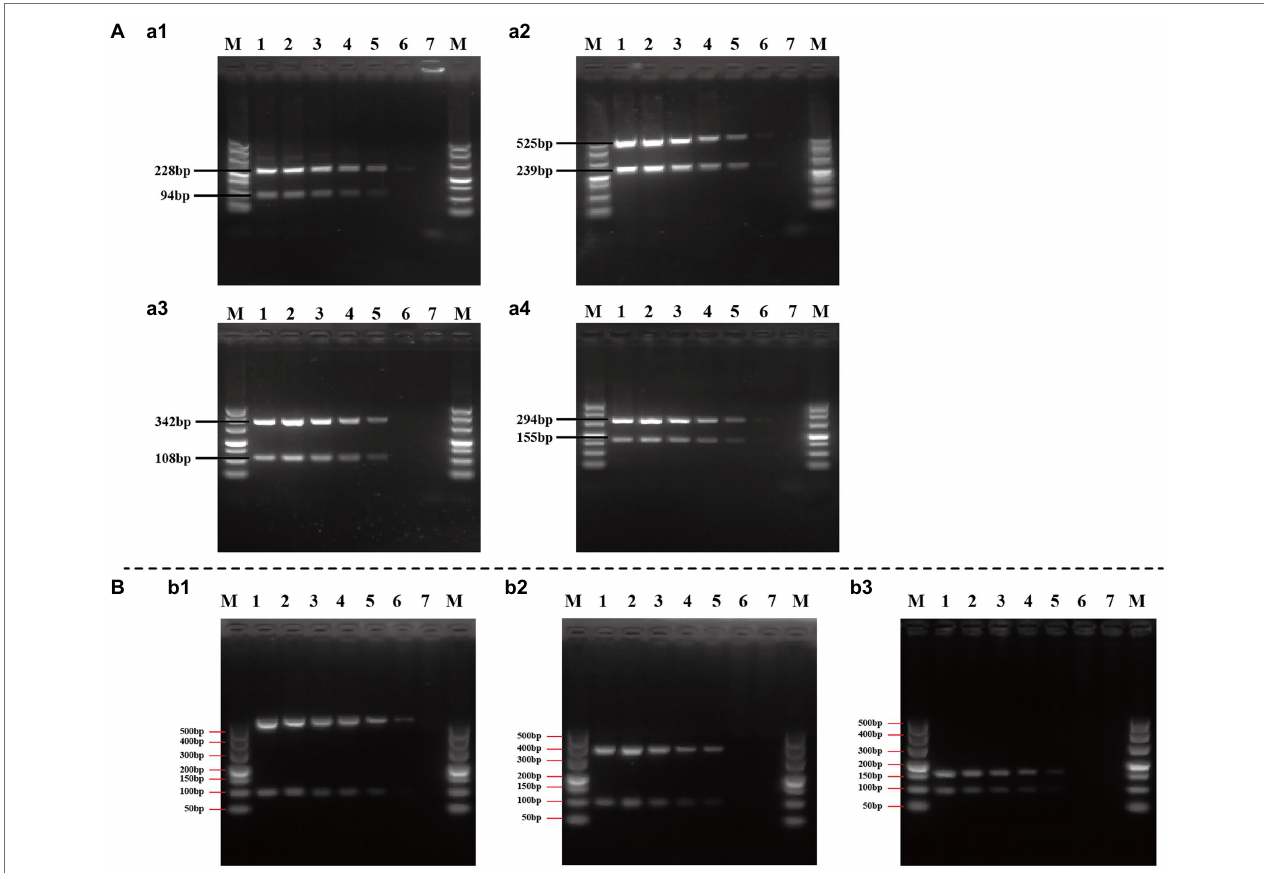
FIGURE 6 | Evaluation of the sensitivity of duplex (A) and multiplex (B) PCR assay. (a1–a4) : Cronobacter sakazakii ATCC 29544 ™ , C. sakazakii ATCC 29544 ™ , Cronobacter malonaticus LC07, and Cronobacter turicensis LC08 as template to evaluate the sensitivity of duplex PCR assay based on Cro_set, Sak_set, Mal_set, and Tur_set; (b1–b3) : C. sakazakii ATCC 29544 ™ , C. malonaticus LC07, and C. turicensis LC08 as template to evaluate the sensitivity of multiplex PCR assay based on Cro_set. Lane M: DNA marker; lanes 1–6: template of pure culture from 2.5 × 10 7 to 2.5 × 10 2 CFU/ml; and lane 7: negative control without